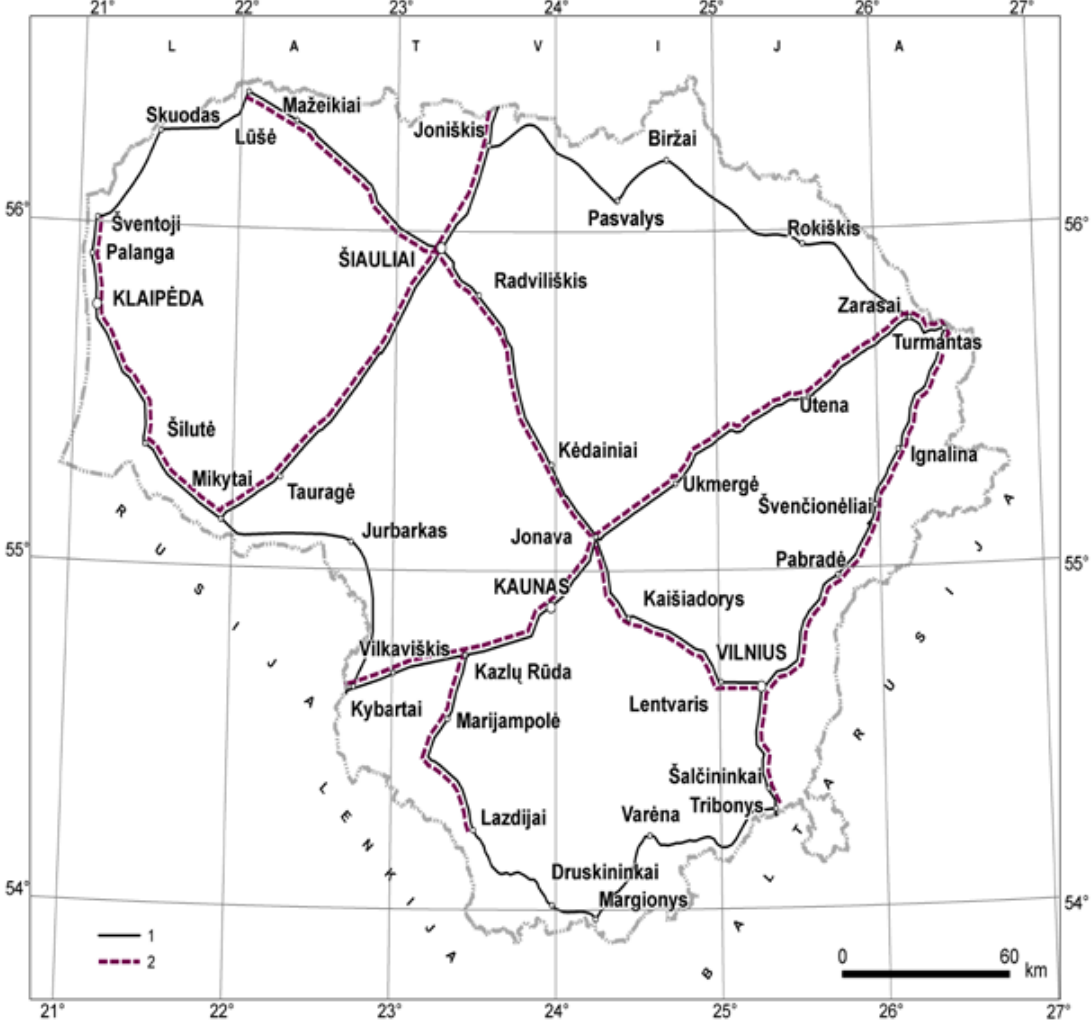
Fig 1. First-level geodetic levelling network of